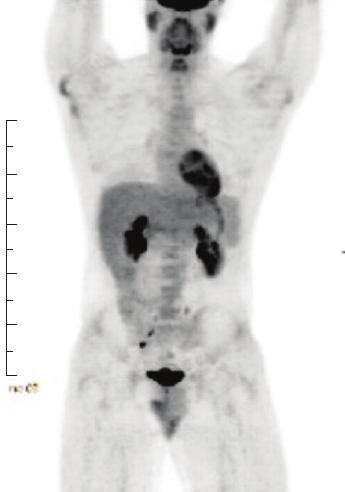
Figure 6: Restaging MIP scan showed complete response to treat- ment.